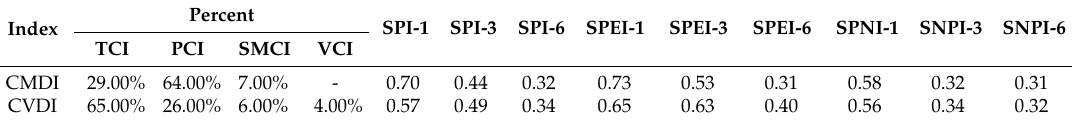
Table 2. Correlations of Combined Meteorological Drought Index (CMDI) and Combined Vegetation drought (CVDI) with in situ drought